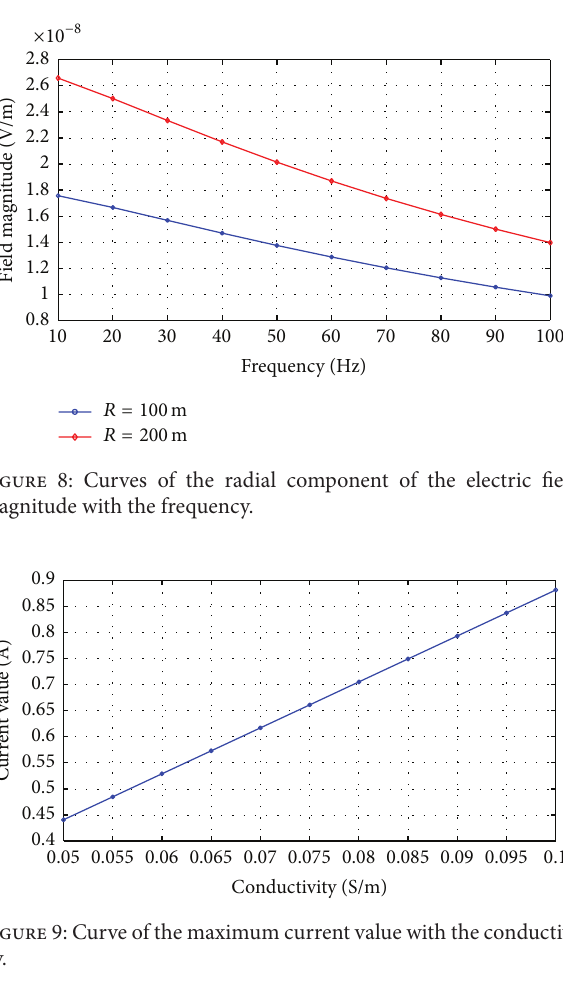
Figure 6: Curves of the received voltage value on the ground.